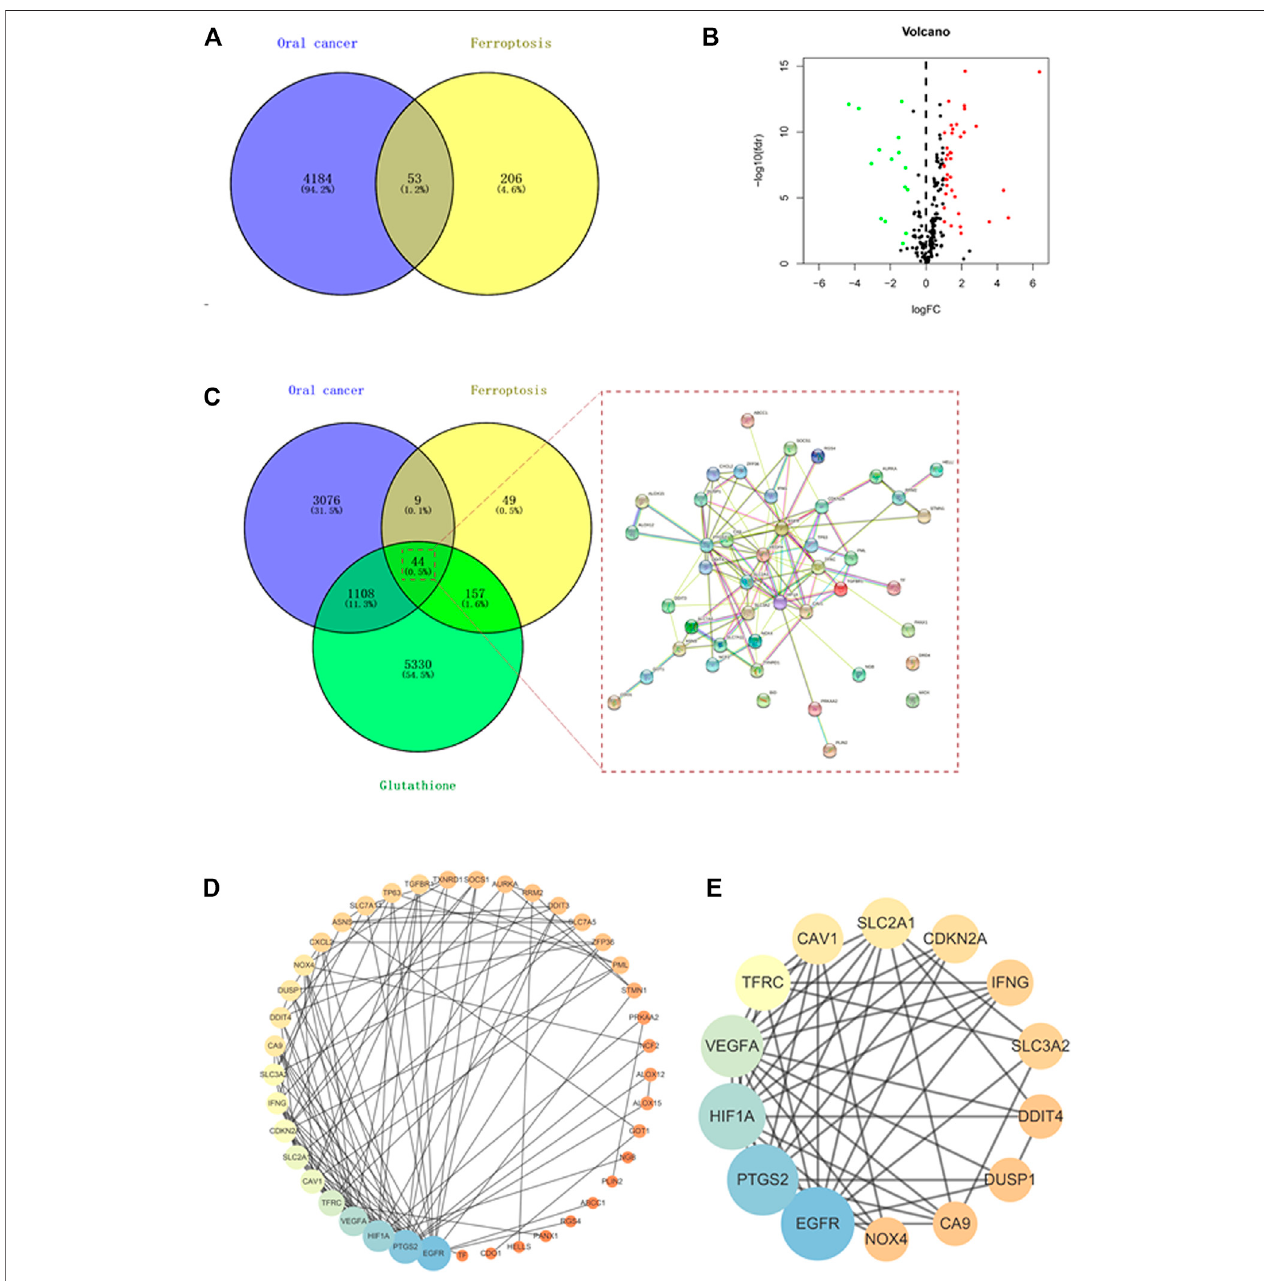
FIGURE 1 | Network pharmacology identi fi ed the anti-oral cancer genes involved in targeting ferroptosis by glutathione (GSH). (A) Venn diagram showing the interactinggenesassociatedwithoralcancer(OC)andferroptosis. (B) Volcanoplotshowingthedifferentialexpressionofferroptosis-associatedgenesinOC.Thegenes with FDR < 0.05 and |log2 fold change| > 1 were considered as differentially expressed genes. Green dots represent downregulated genes, and red dots represent upregulated genes. (C) Venn diagram showing the interacting genes associated with OC, ferroptosis, and GSH. (D) Protein – protein interaction (PPI) of OC-, ferroptosis-, and GSH-associated genes. (E) Cytoscape analysis identi fi ed 14 core targets of GSH for treating OC by targeting ferroptosis.